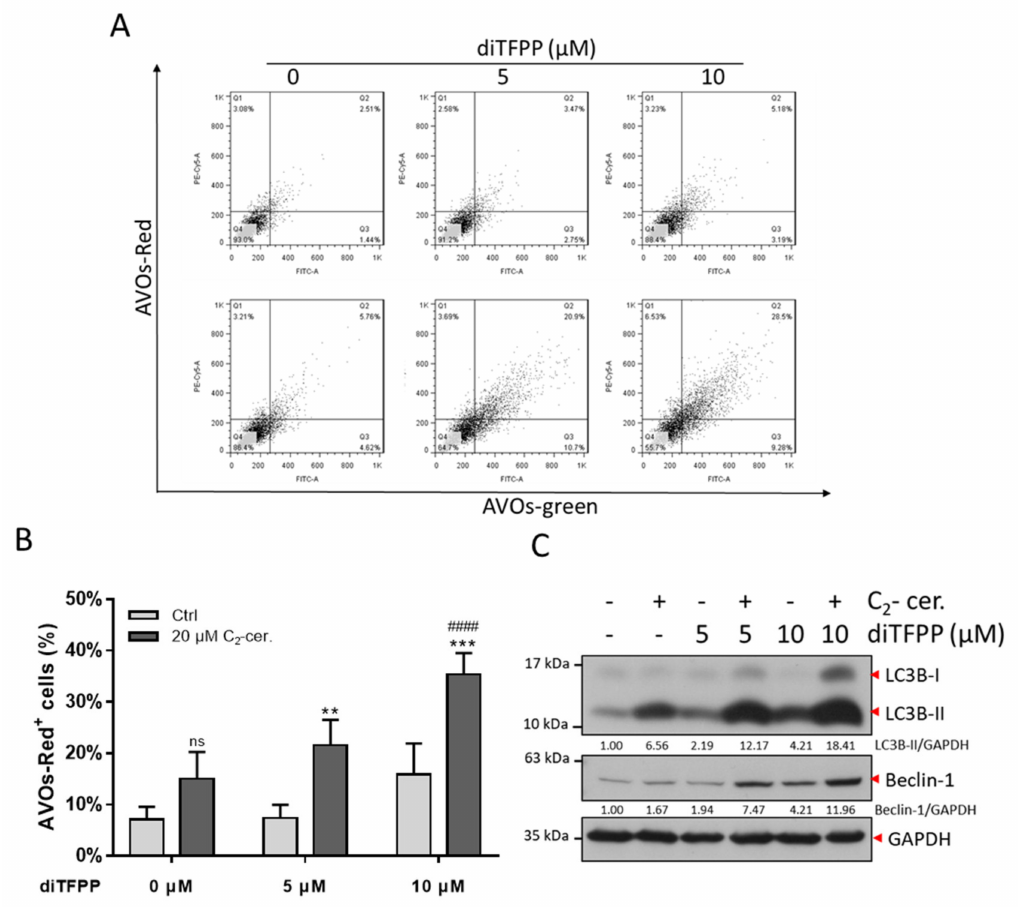
Figure 4. Autophagy is involved in diTFPP/C 2- ceramide treatment. ( A ) AO staining after 24 h of diTFPP/C 2- ceramide treatment. The x-axis indicates green fluorescence, and the y-axis indicates red fluorescence (AVO-positive cells). ( B ) Quantification of (A). ns, no significant p >0.05, ** p < 0.01, *** p < 0.001 compared with the control groups. #### p < 0.0001 compared with the C 2 -ceramide alone group; all data are presented as the means ± SD of four independent experiments. ( C ) Western blot analysis of autophagic proteins after 24 h of diTFPP/C 2- ceramide treatment. GAPDH as an internal